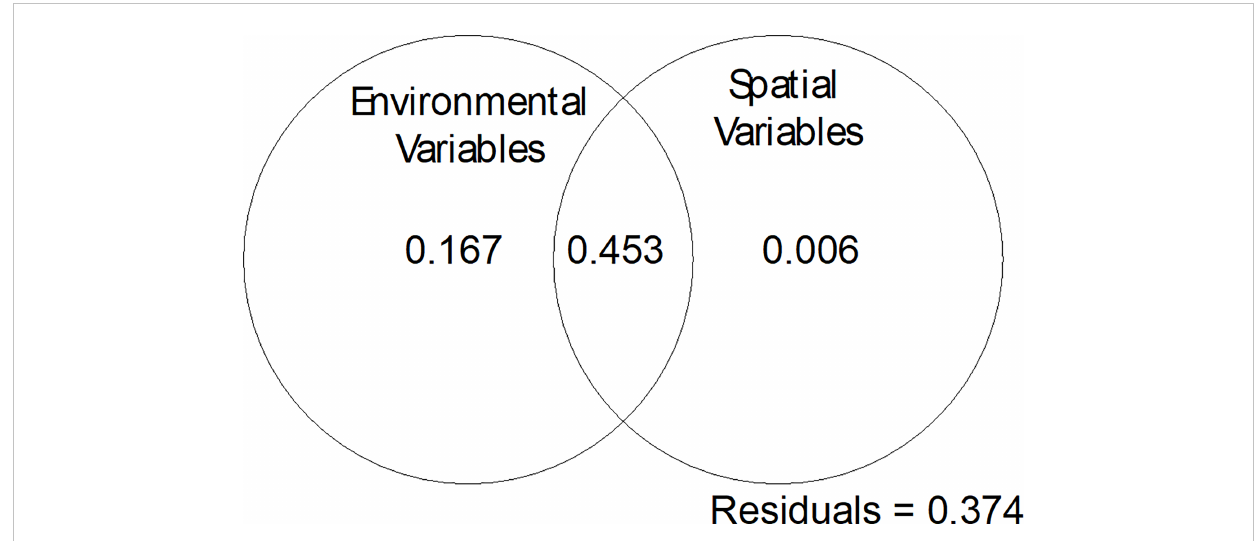
FIGURE 8 Variation partitioning plot for the Hellinger transformed species data, the selected environmental variables (depth, substratum, bathymetric criticality to the M 2 tide and amplitude of the M 2 tide) and spatial variables (sample